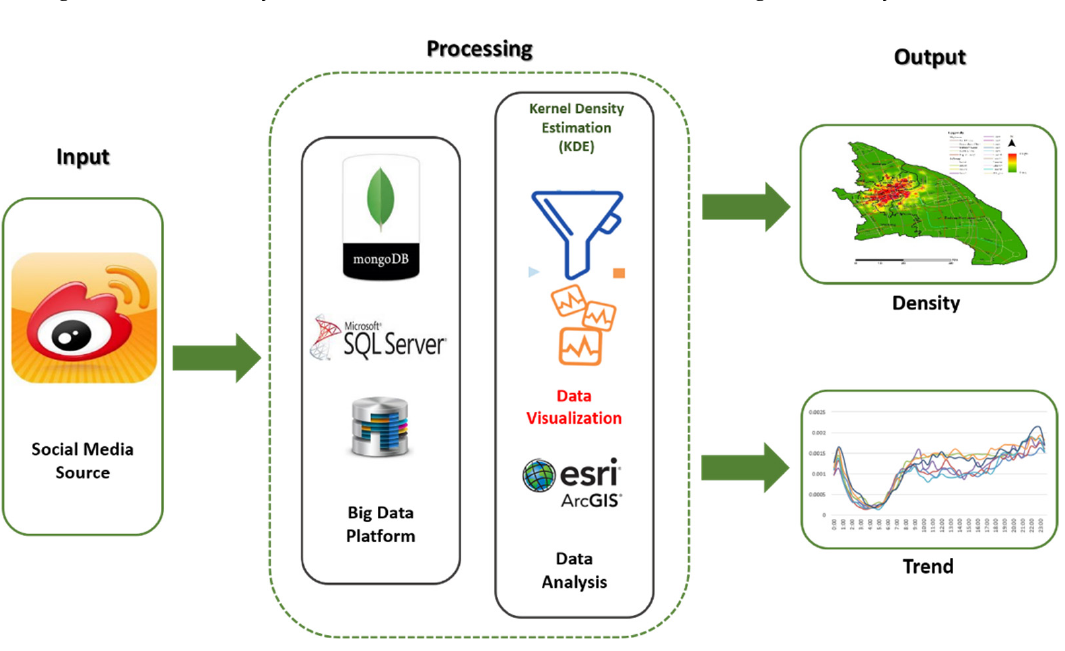
Figure 3. A general framework for check ‐ in behavior analysis.